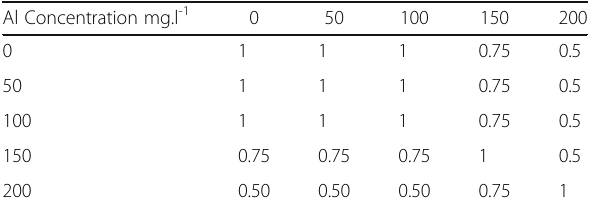
Table 4 Similarity indices according to Nei and Li's coefficients of treated date palm callus with several concentrations of Al obtained by SDS-PAGE electrophoresis